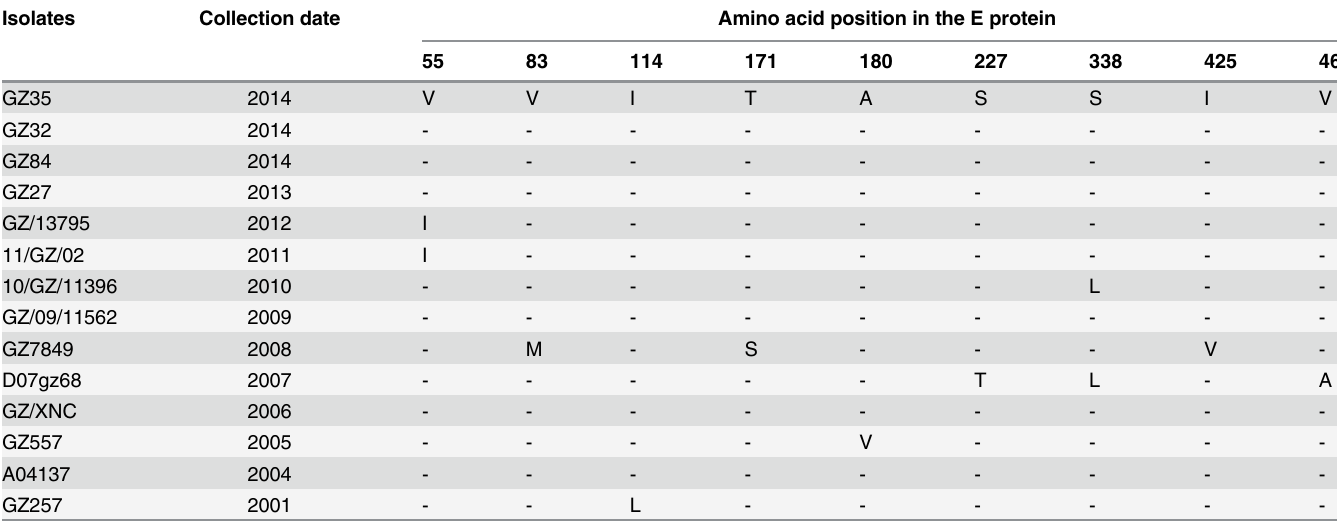
Table 2. Summary of mutations resulting in amino acid changes in envelope (E) protein gene of DENV-1 genotype 1 isolates in Guangdong prov- ince during 2001 – 2014.